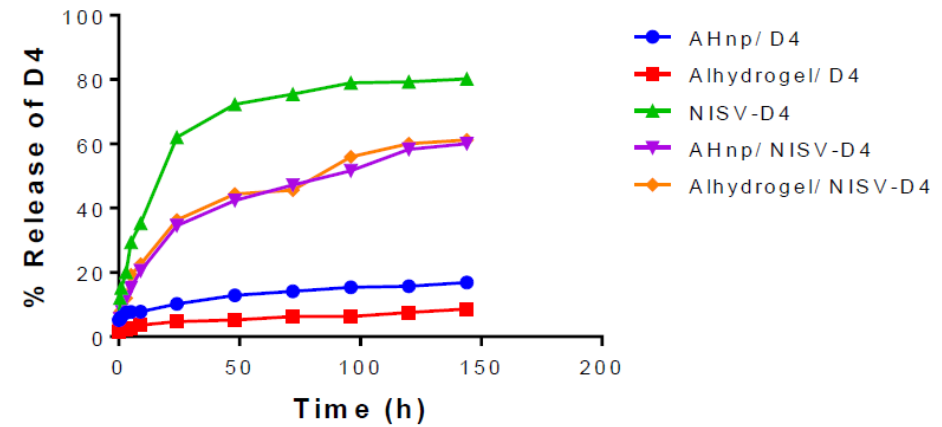
Figure 1. In vitro release kinetics. Nanoparticle formulations were suspended in 1 × PBS at 37 ℃ .